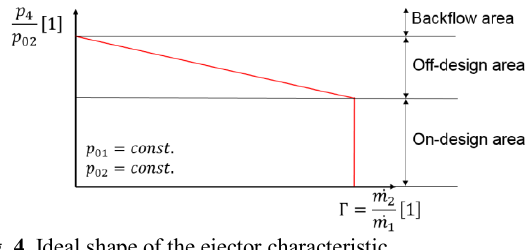
Fig. 4. Ideal shape of the ejector